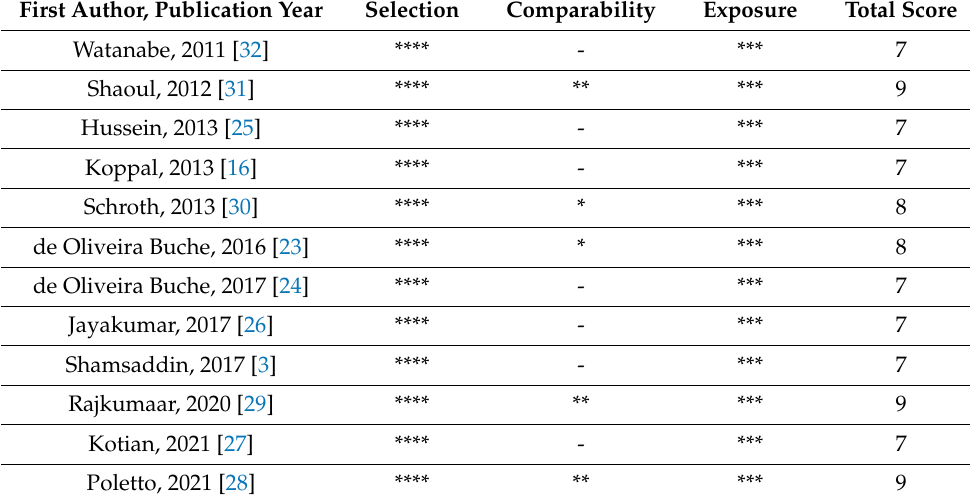
Table 2. Quality score of the